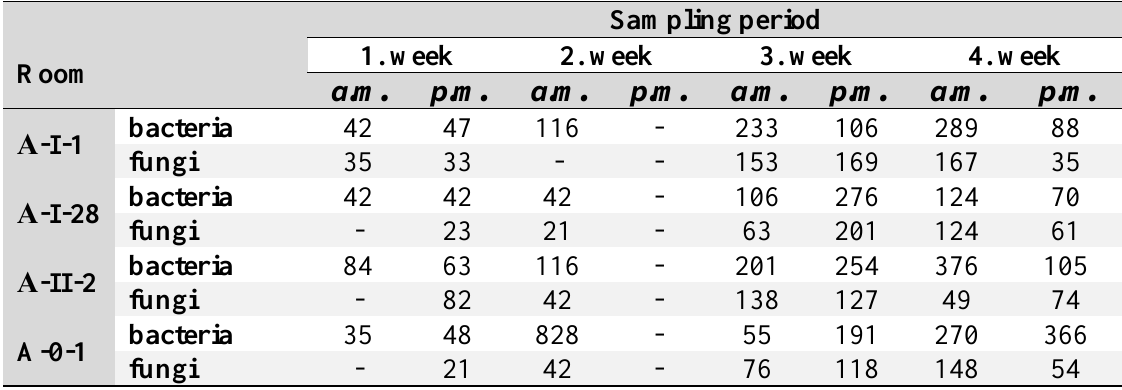
Table 1. The total number of bacteria/fungi (cfu/m 3 ) in indoor air in faculty's room during the month of March.